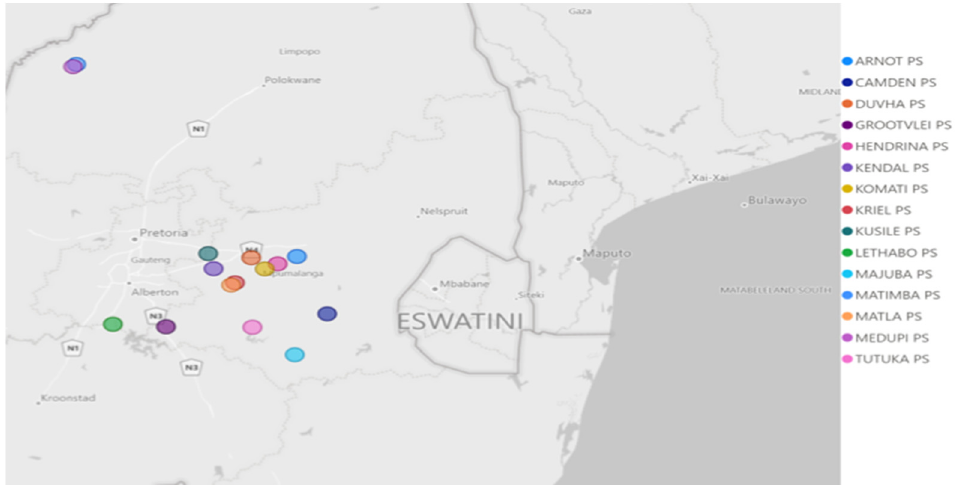
Figure 4. Location of 15 key South African coal-fired power stations.